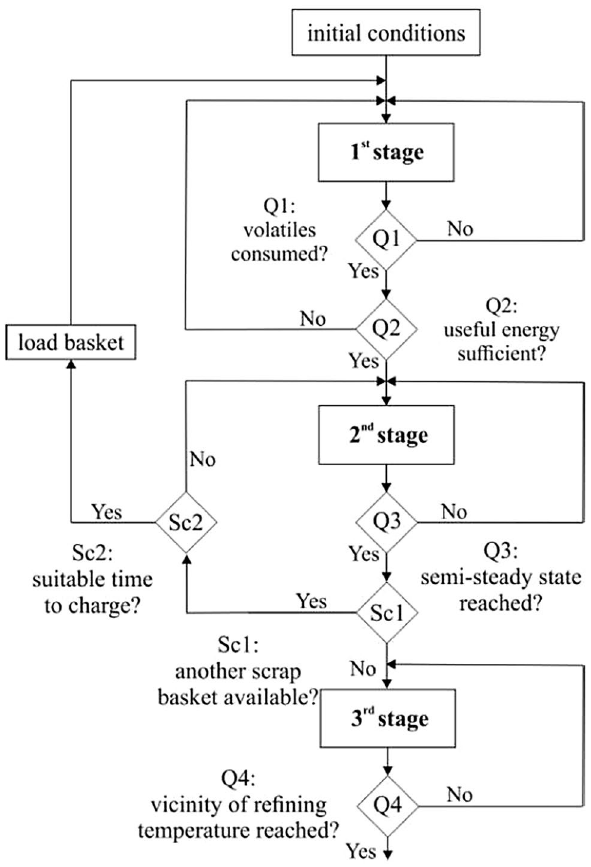
Fig. 22 Conceptual framework of the presented model [36]